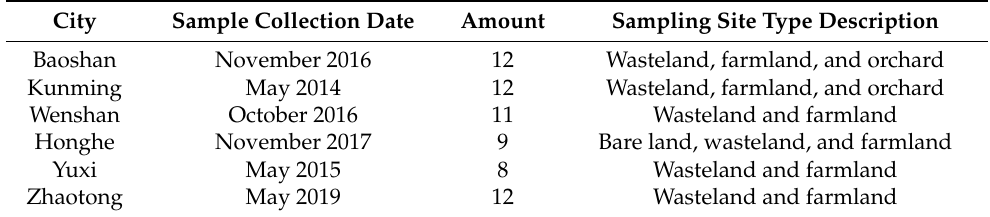
Table 1. Information on and descriptions of samples of soil fugitive dust around the urban areas in six